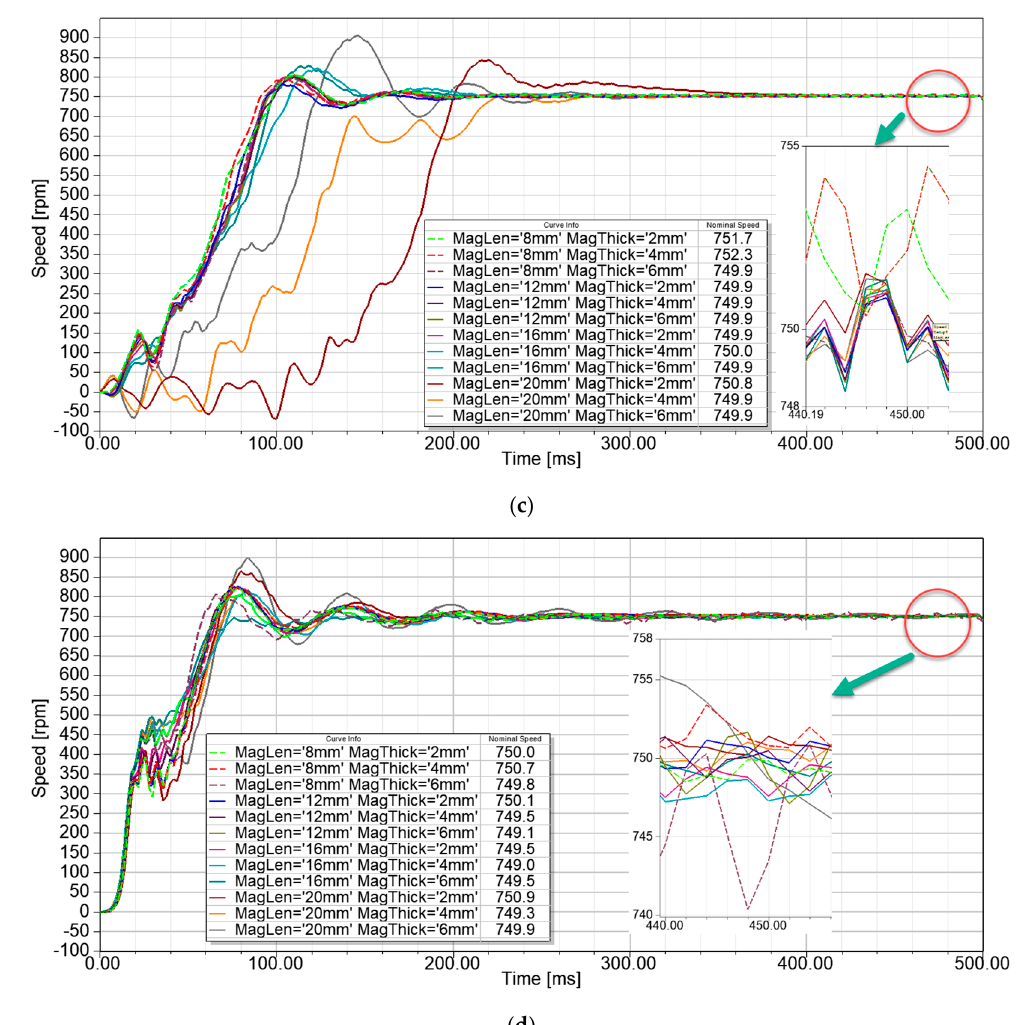
Figure 4. Performance of the motor types for different magnet sizes. ( a ) Type-A, ( b ) Type-B, ( c ) Type-C, ( d ) Type-D.